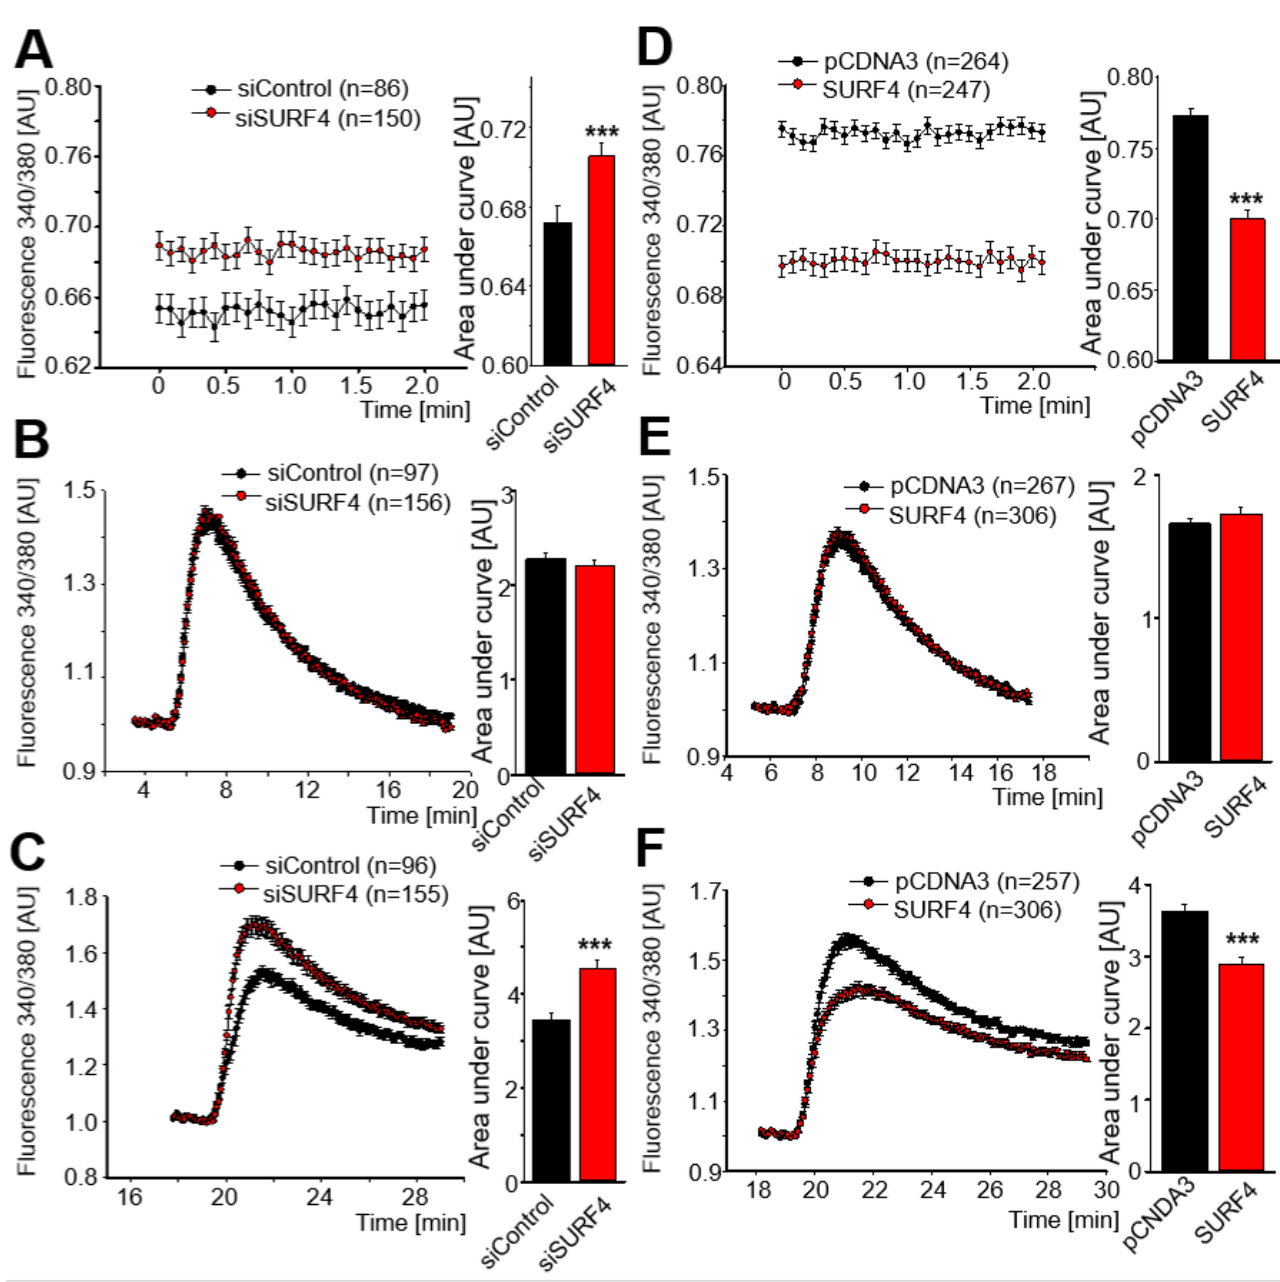
Figure 7. SURF4 conditions SOCE activity. ( A , B ) Human neuroblastoma cells were transfected with SURF4 siRNA ( A ) or with a plasmid to overexpress SURF4 ( B ), and after 48 h the levels of calcium were measured by using FURA2. Data are the mean ± SEM of 4–7 independent experiments. *** p < 0.001 vs. control by Student’s t-test. ( C , D ) Cells transfected with SURF4 siRNA ( C ) or SURF4 plasmid ( D ) were exposed to 0 extracellular calcium, and intracellular Ca 2+ changes in response to ER depletion by thapsigargin were measured using FURA2. Data are the mean ± SEM of 4–6 independent experiments. ( E , F ) Cells were transfected with SURF4 siRNA ( E ) or SURF4 plasmid ( F ) during 48 h, and SOCE activity (induced by ER Ca 2+ release with thapsigargin) was evaluated with FURA2 following re-addition of Ca 2+ to the bathing solution. Data are the mean ± SEM of 5–7 independent experiments. *** p < 0.001 vs. control by Student’s t -test.